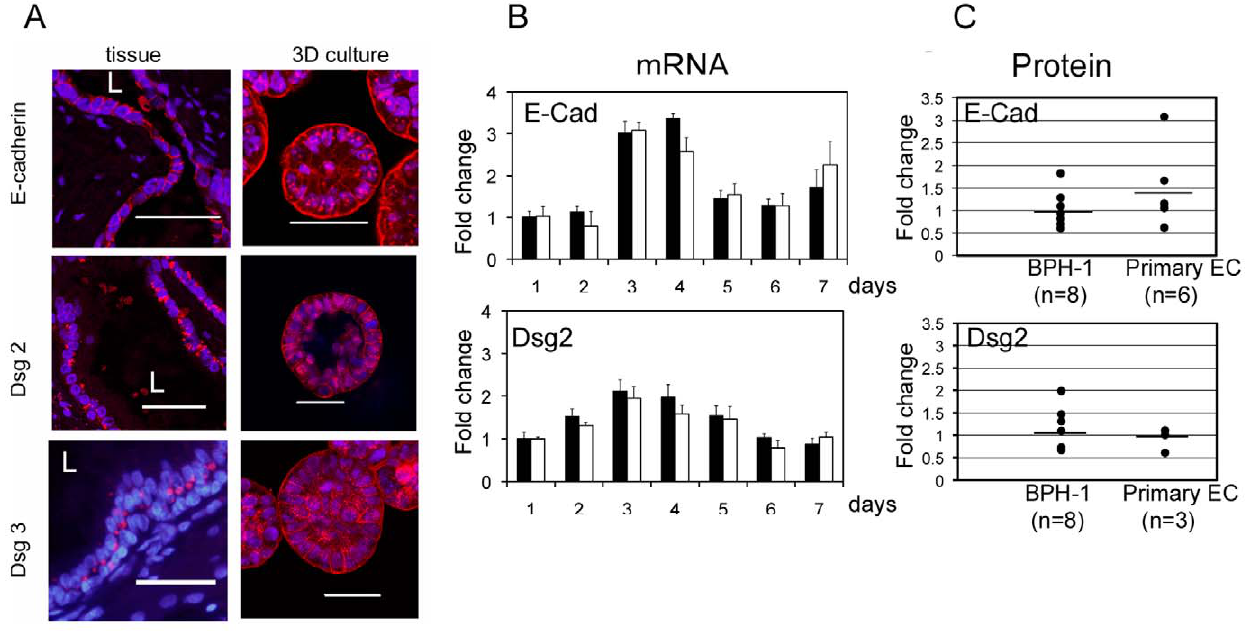
Figure 2. Stroma does not effect E-cadherin or Dsg2 mRNA or protein expression levels. (A). The localisation of E-cadherin and Desmogleins in human tissue and BPH-1 acini sections by immunostaining for E-cadherin, Dsg2 or Dsg3 (red) (A). Nuclei were counterstained with DAPI (blue), bars =50 m m, L = lumen. (B). TaqMan assay was performed on mRNA isolated from 3D BPH-1 acini cultured with (white bars) or without stroma (black bars), over 7 days culture shows that stroma does not increase E-Cadherin or Dsg2 mRNA expression at any time-point. The average fold difference in gene expression was expressed relative to GAPDH. Error bars represent standard deviation of three replicates and the experiment was reproduced twice. (C). Quantitative western blotting was performed on BPH-1 cells or primary epithelial cultures (primary-EC) grown in Matrigel with or without stroma. The levels of E-cadherin or Dsg2 protein expression did not significantly increase in either BPH-1 acini or primary acini cultured in the presence of stroma. Protein levels were measured by densitometric analysis and normalised to b -actin. A mean fold change in protein expression was calculated for cells grown with stroma in comparison to those without stroma. Individual experiments are represented as dots and the mean value is shown by the bar.